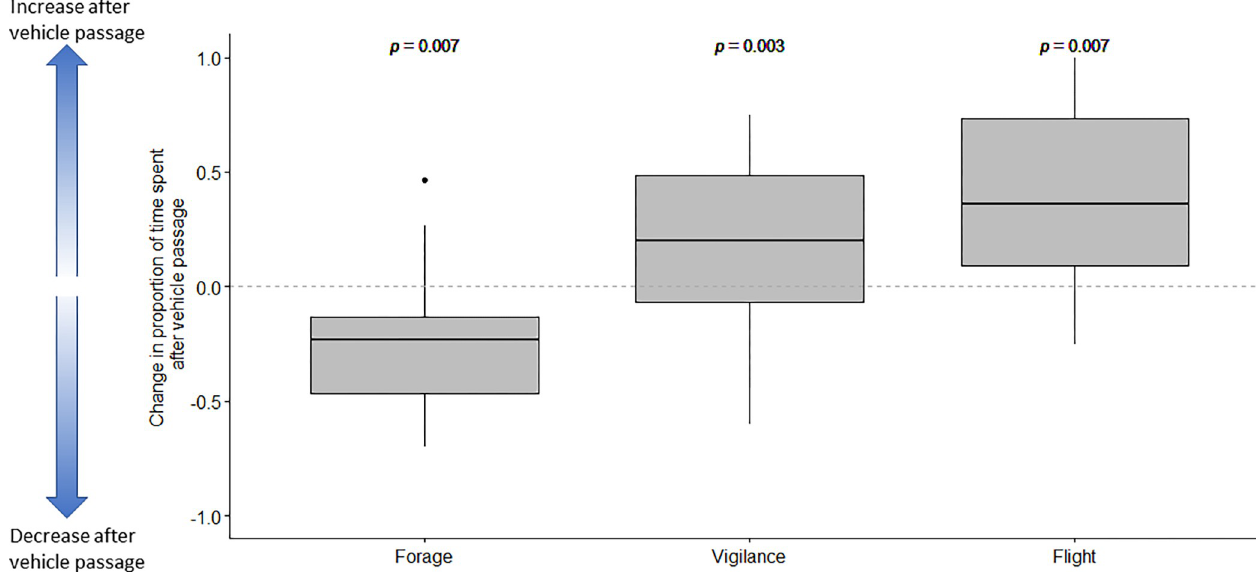
Fig 2. Change in proportion of time spent foraging, vigilant, and fleeing after vehicle passage. Larger positive values indicate an increase in proportion of time spent in any given behavior after vehicle passage (i.e., vigilance and flight behaviors) while smaller values (i.e., negative values) indicate a reduction in the proportion of time spent in a given behavior (i.e., foraging). Significant p-values (from a one sample t-test) indicate a that the sample mean is not equal to 0. Each boxplot visualizes the median, hinges representing the 25 th and 75 th percentiles, and whiskers (i.e., the largest value that is no further than 1.5 � IQR from the